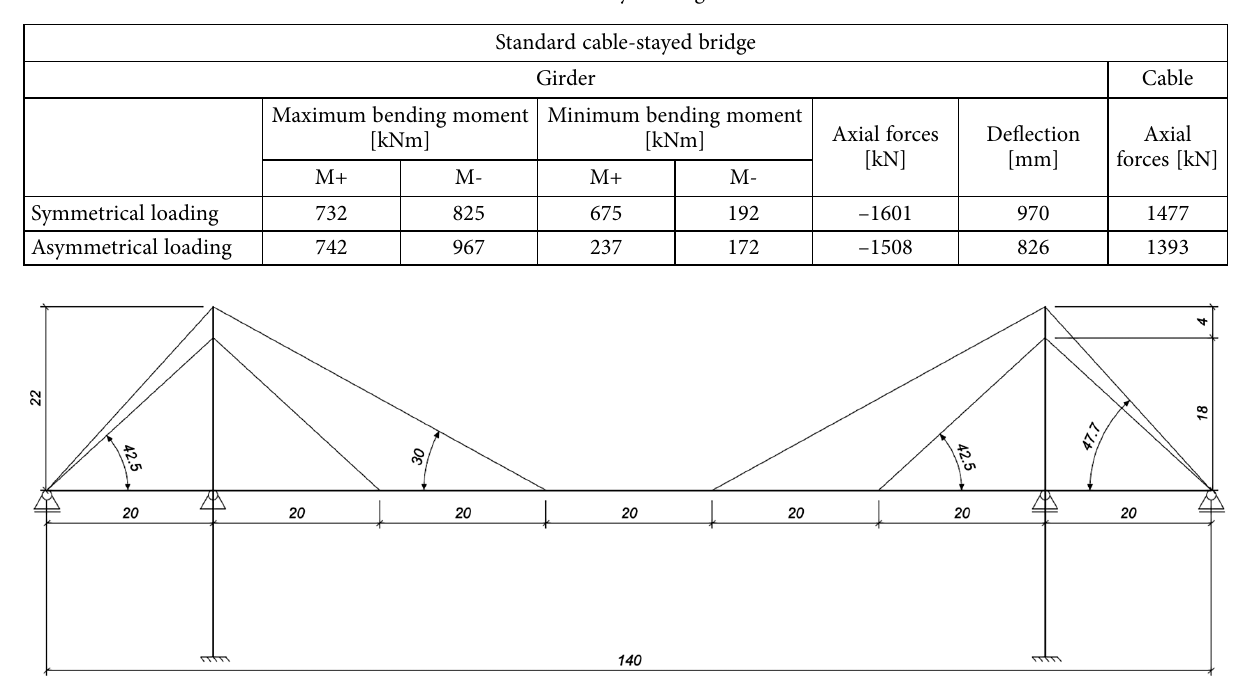
Figure 9. Standard